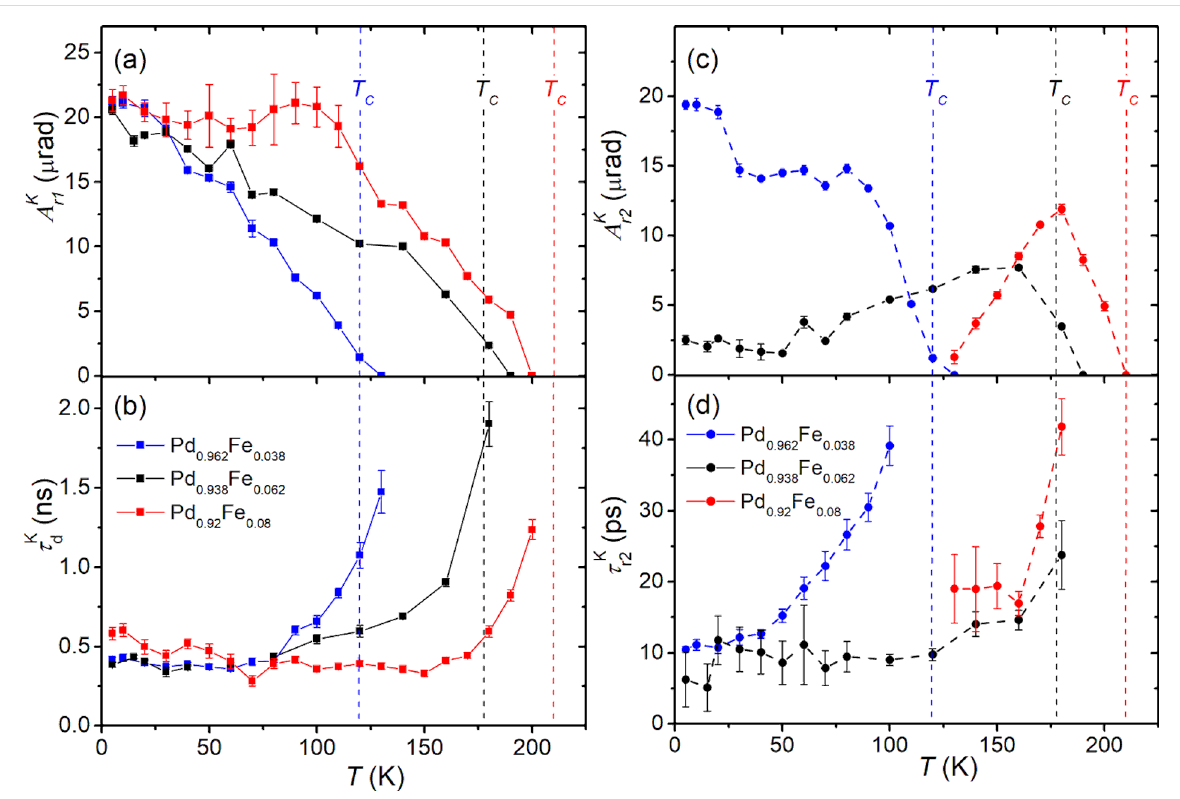
Figure 4: Temperature dependences of the amplitudes of the fast (squares/solid lines) (a) and the slow (circles/dashed lines) (c) photoinduced demagnetization components; characteristic times (b) of the magnetization recovery (squares/solid lines) and (d) of the slow demagnetization (circles/dashed lines) of the Pd 0.962 Fe 0.038 (blue), Pd 0.938 Fe 0.062 (black), and Pd 0.92 Fe 0.08 (red) epitaxial films.